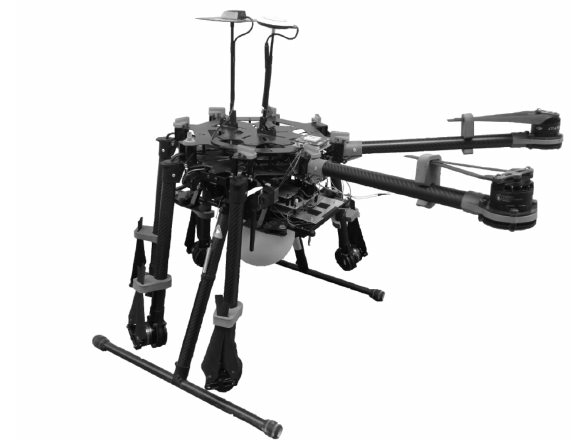
Figure 2. Opt-copter has 8 arms and all of them are able to be folded